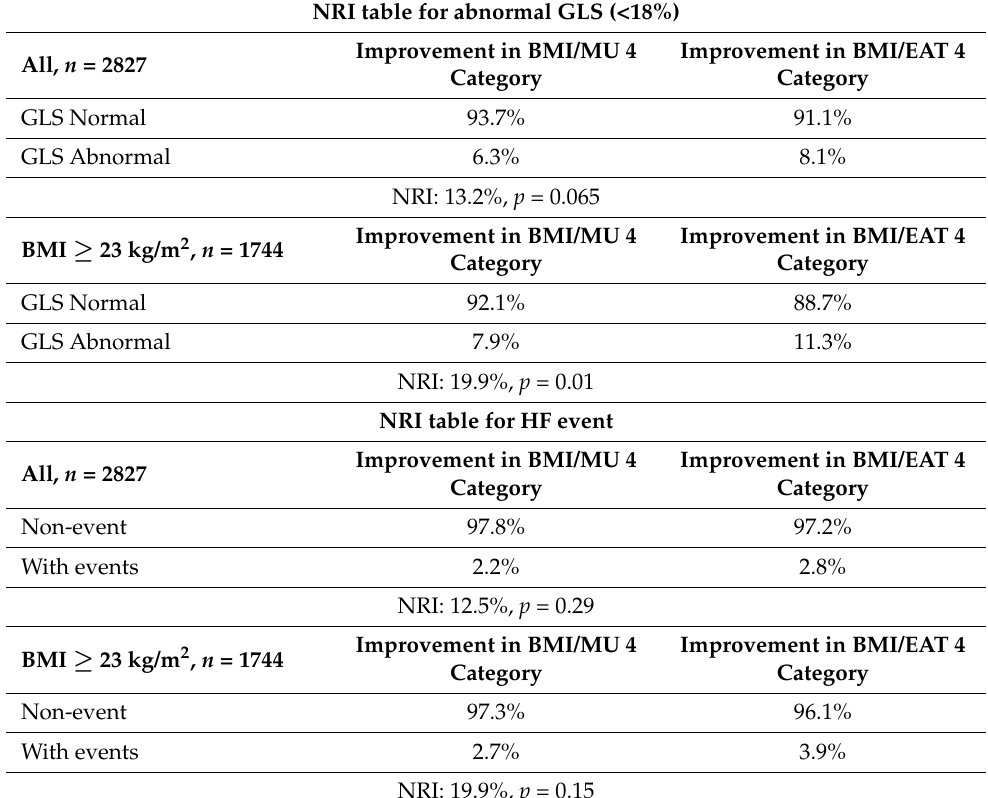
Figure 5. Comparison of abnormal left atrium (LA) strain and atrial fibrillation (AF) occurrence between obesity phenotypes utilizing body mass index (BMI) and metabolically unhealthy (MU) status or BMI and epicardial adiposity thickness (EAT) classification system. A large fraction of normal LA strain and non-event (AF) individuals from low BMI/MU were reclassified into the low BMI/low EAT category the in normal-weight population. Table 8. Reclassification of abnormal LV strain (GLS) and HF event based on BMI/MU and BMI/EAT categories NRI table for abnormal GLS (< 18%)